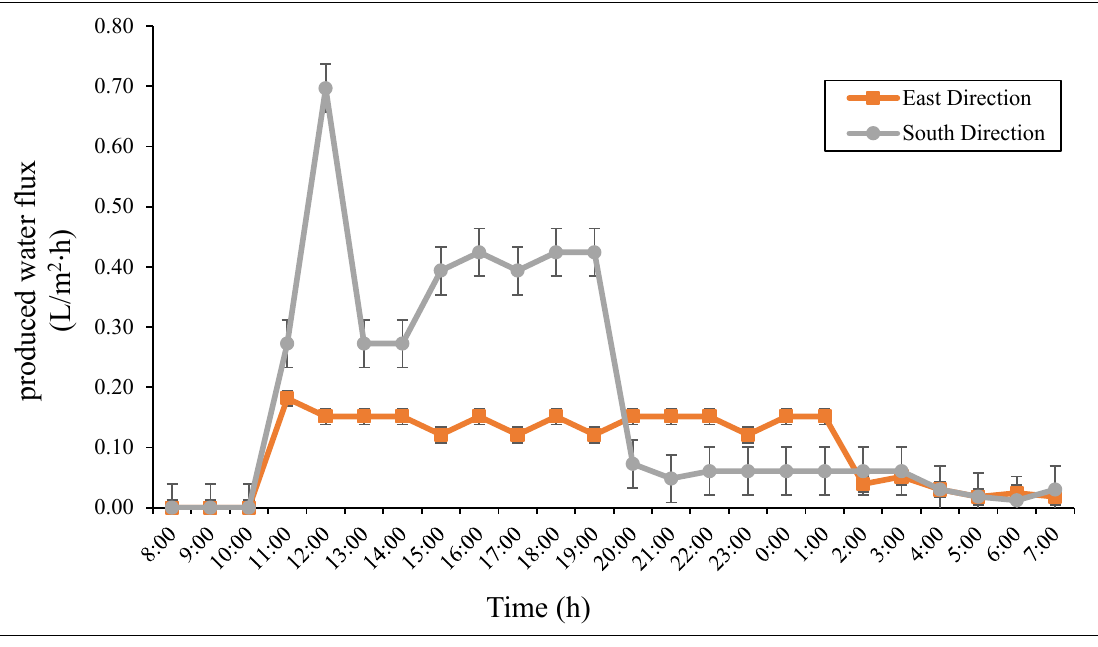
Figure 5. Effect of the unit orientation on the water production rate.